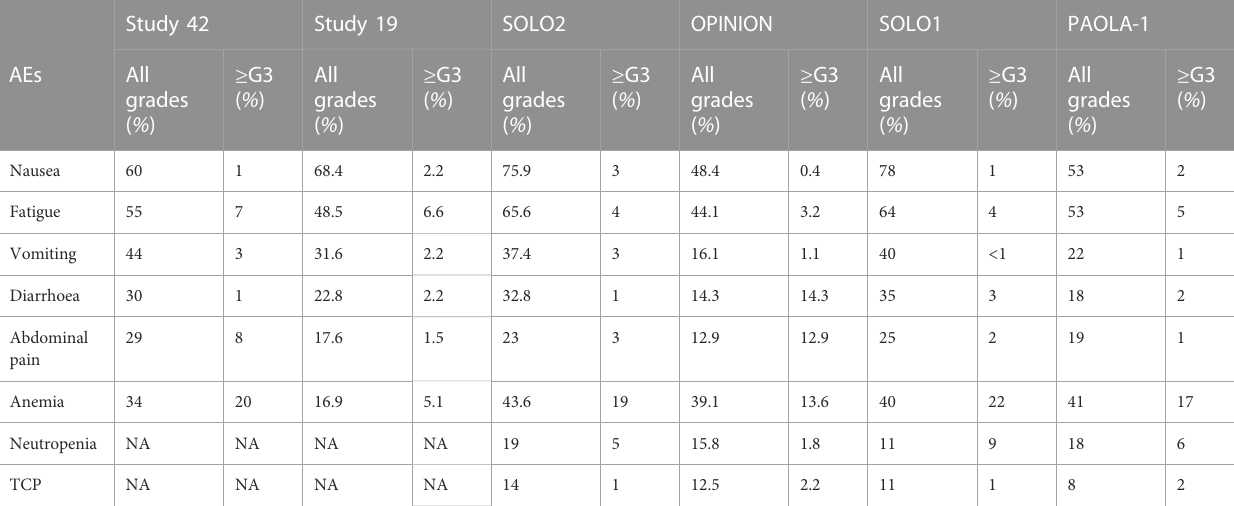
TABLE 3 Adverse events of Olaparib in clinical trials according to CTCAE.